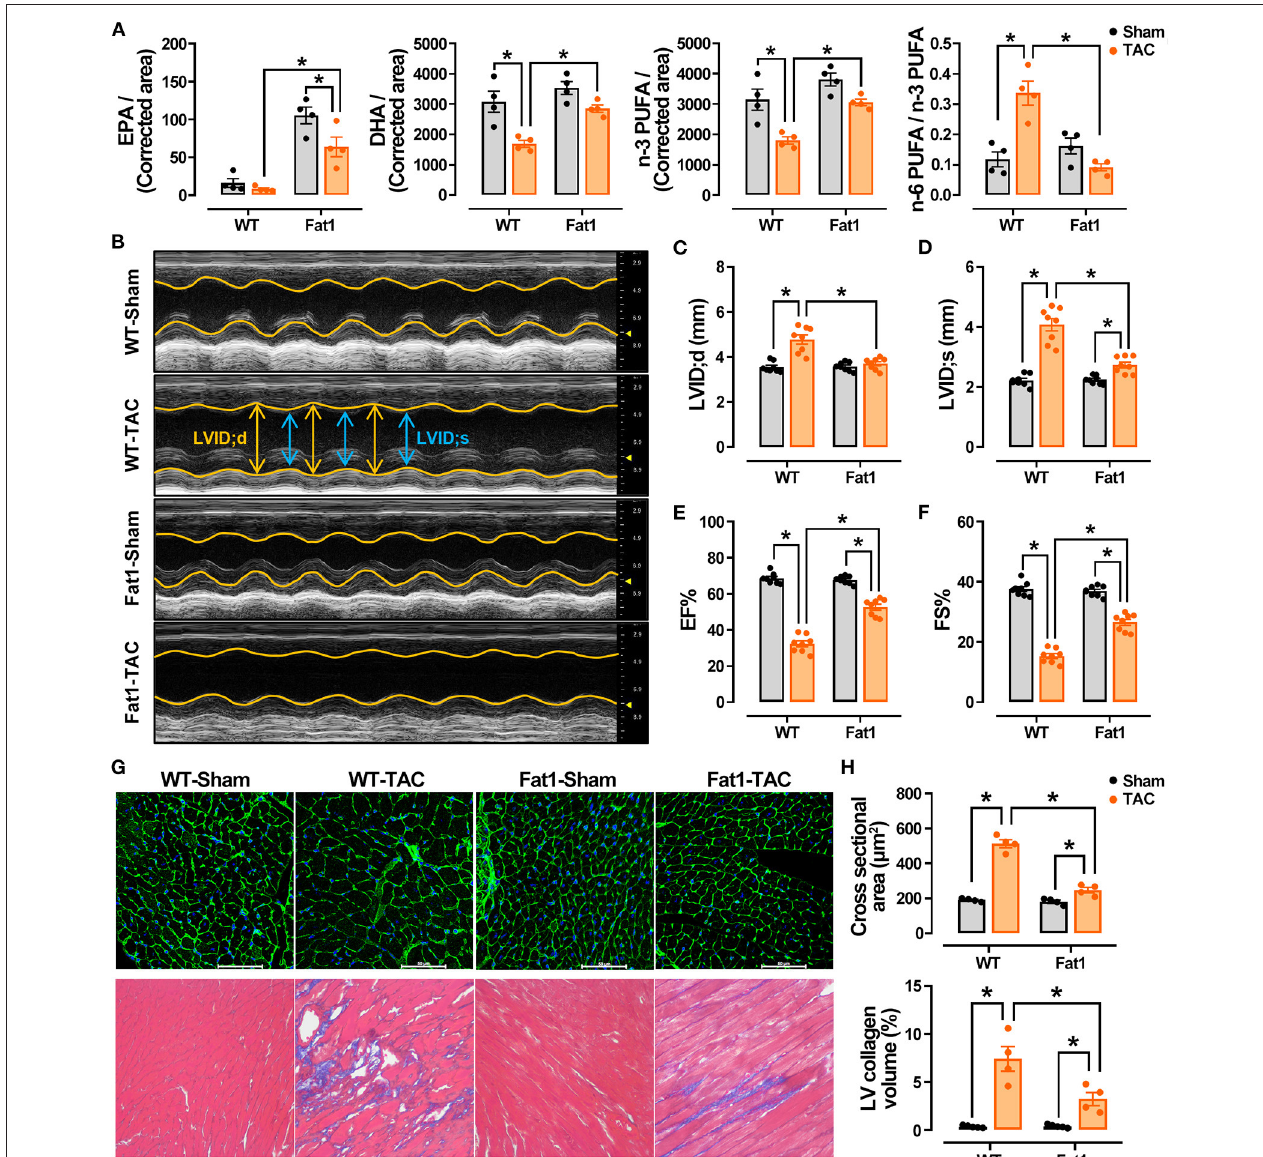
FIGURE 1 | Endogenous n-3 PUFAs and echocardiographic measurements in WT and fat-1 mice with or without pressure overload. Fat-1 transgene increased endogenous n-3 PUFAs in normal and pressure overload hearts and lowered the ratio of n-6 to n-3 PUFAs in pressure overload hearts (A) . N = 4 for each group. EPA, eicosapentaenoic acid; DHA, docosahexaenoic acid; PUFA, poly unsaturated fatty acid. The M-mode recordings of the four groups are shown in (B) . Transverse aortic constriction (TAC)-induced pressure overload significantly increased the internal diameters at diastole (C) and systole (D) in WT mice, whereas these two indices were lower in fat-1 mice than in WT mice. Cardiac contractile function indices, including EF (E) and FS (F) , showed that the function was preserved in the fat-1 TAC group. Pressure overload significantly increased the size of cardiomyocytes and fibrosis, which was significantly reduced in the Fat1-TAC group (G,H) . N = 8 for each group, subjected to echocardiographic analysis, and N = 4 for each group subjected to histological observation. LV, left ventricle. All data are presented as the means ± SEM. * P < 0.05 between groups.